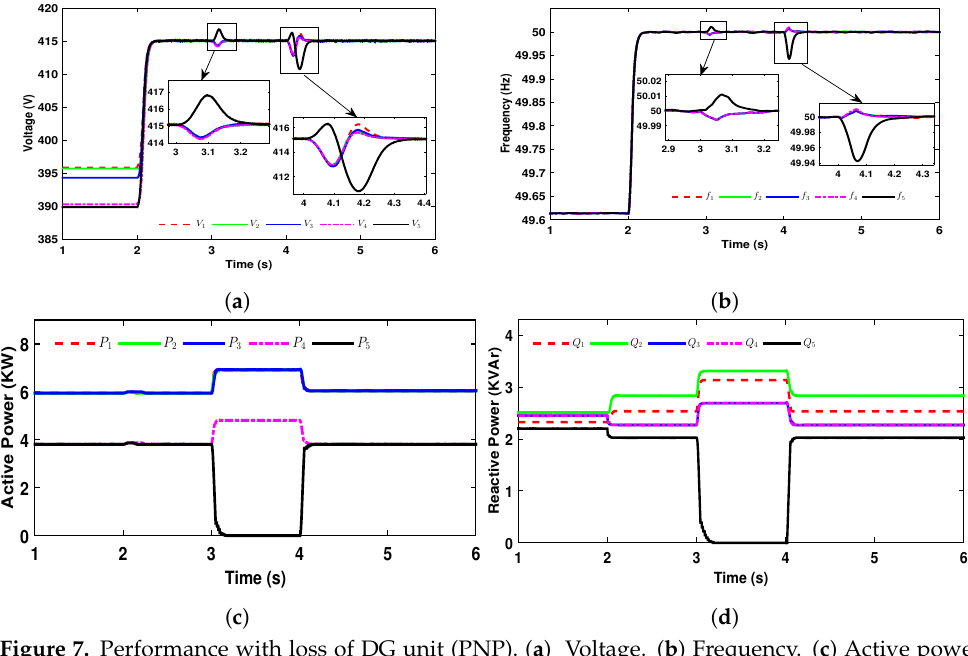
Figure 7. Performance with loss of DG unit (PNP). ( a ) Voltage. ( b ) Frequency. ( c ) Active power. ( d ) Reactive power.